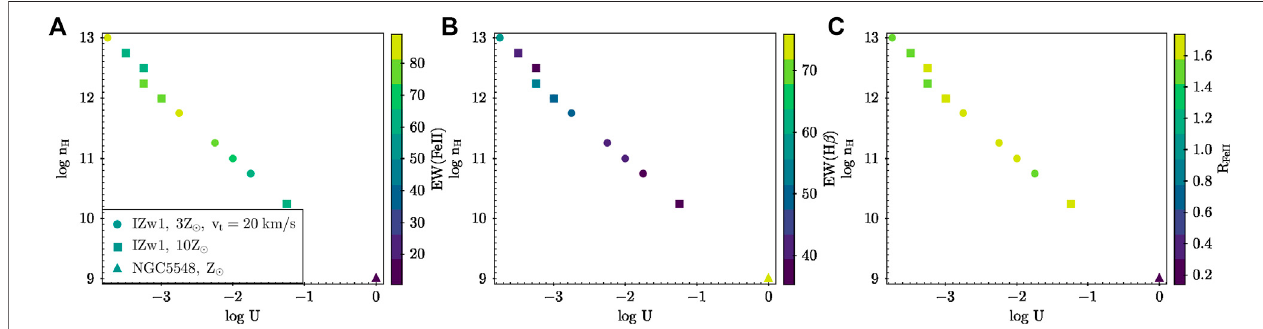
FIGURE 10 | log U − log n H parameter space as a function of: (A) EW(Fe II), (B) EW(H β ), and (C) R FeII . These mark the fi nal fi ltered solutions adopting the steps shown in Figure 9 . The three successful cases (two for I Zw 1 and one for NGC 5548) are shown using respective